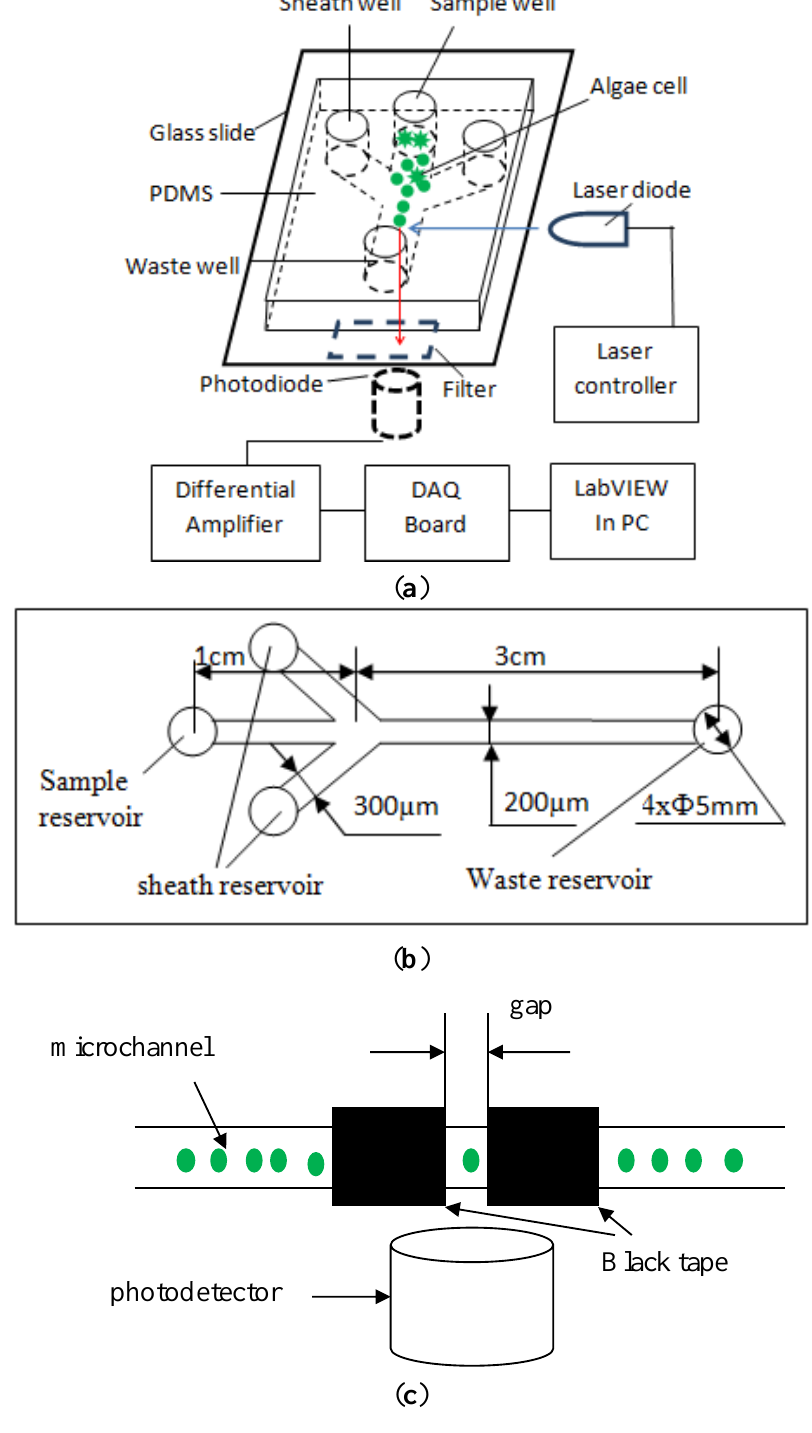
Figure 1. ( a ) The schematic diagram of the chlorophyll fluorescence detection system; ( b ) the dimensions of the microfluidic chip; and ( c ) the schematic diagram of